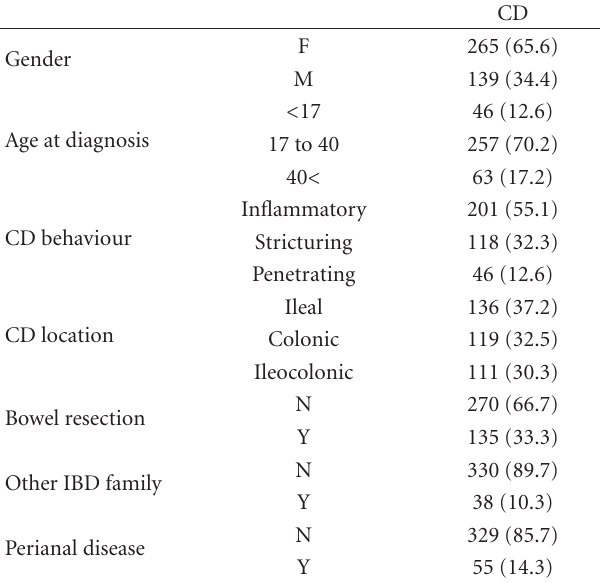
Table 1: Summary of clinical data of CD